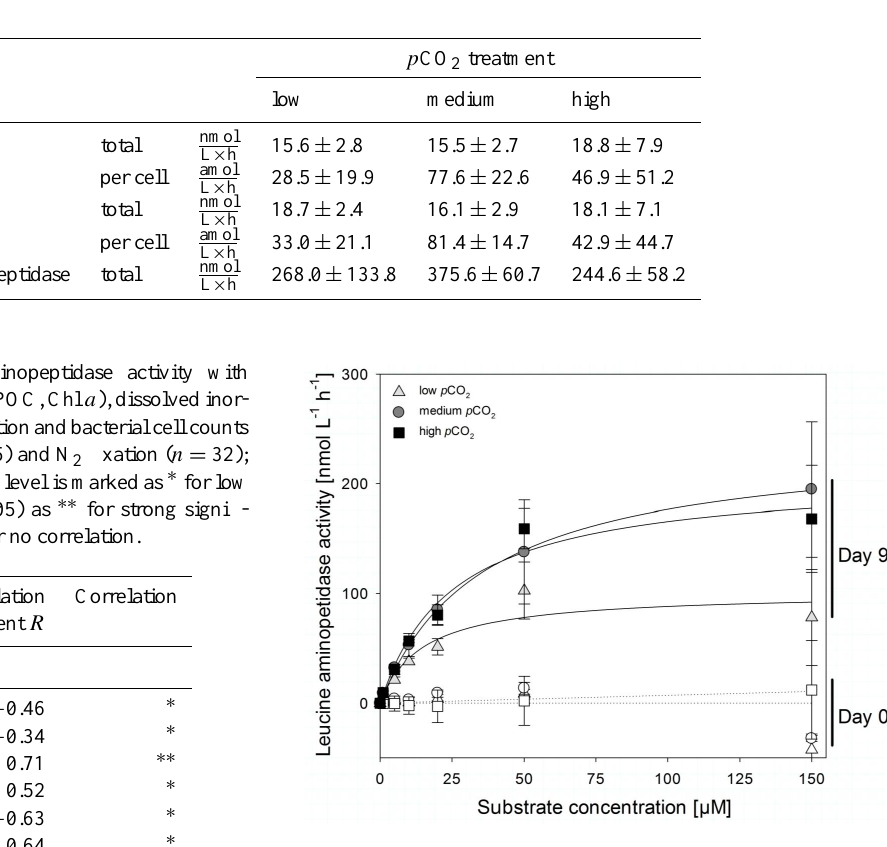
Fig. 8. Aminopeptidase activities on day 0 and day 9 of low (trian- gle), medium (circle) and high (square) p CO 2 treatments. Symbols display the mean of three replicates with standard